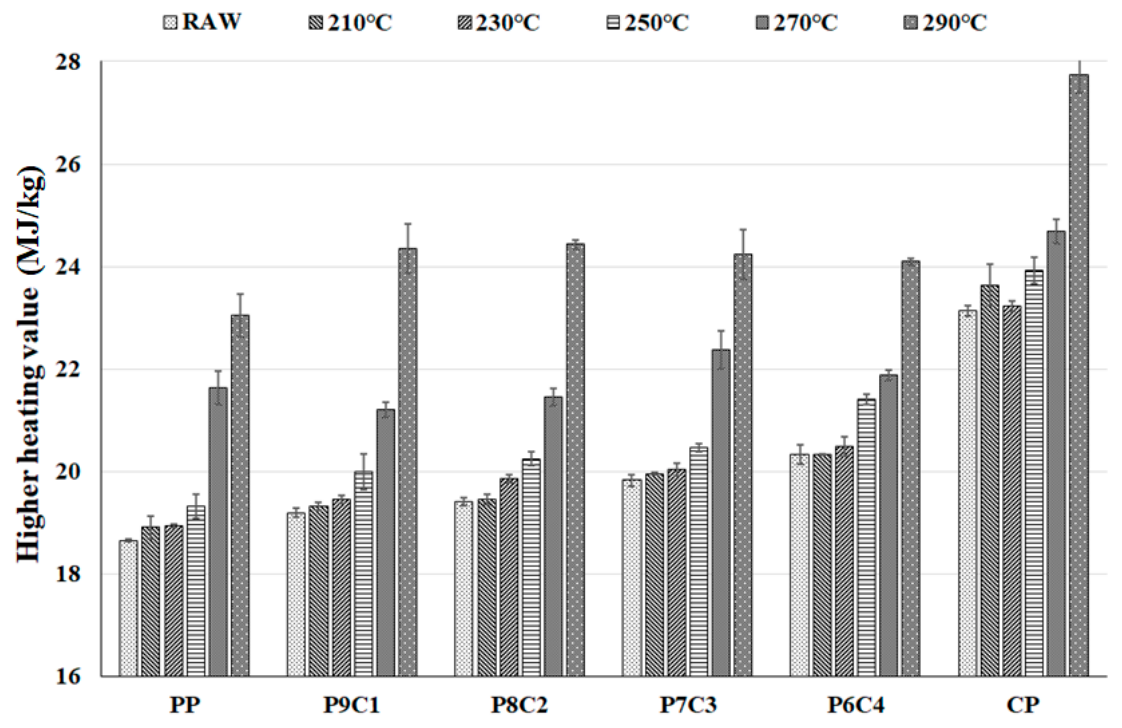
Figure 6. Variation in higher heating value with different torrefaction temperatures.